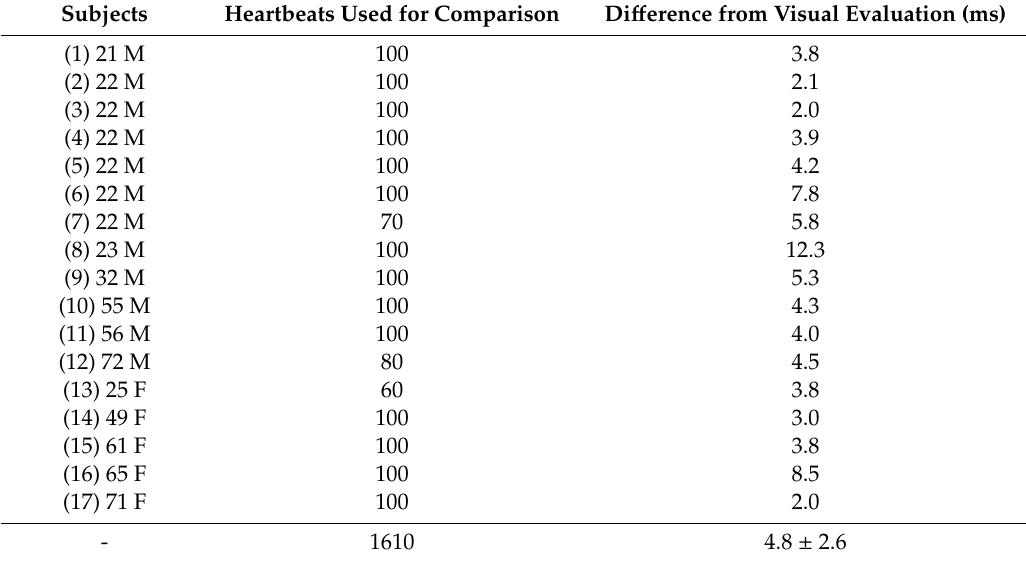
Table 2. Di ff erence in QT-interval measurement between our ECG recognition technique and Table 2. Difference in QT-interval measurement between our ECG recognition technique and visual visual examination.